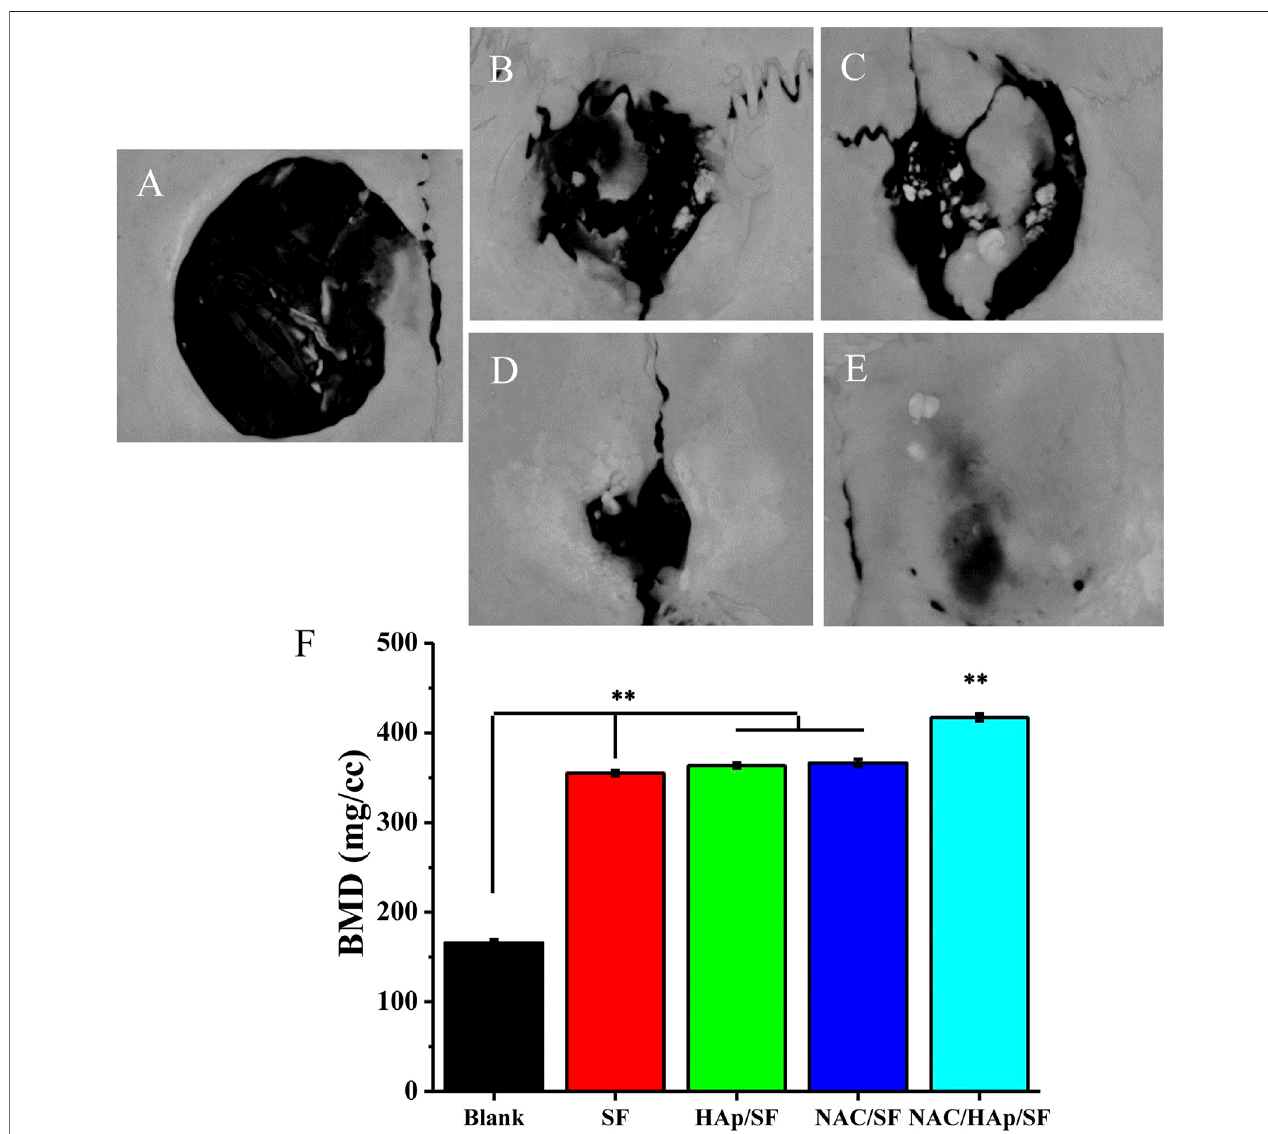
FIGURE10 | CTexaminationof thewhole calvarias (A – E) and bone mineral density ofthe defects (F) 8 weeksafter implantation in vivo (A) blank, (B) SF, (C) HAp/ SF, (D) NAC/SF, and (E) NAC/HAp/SF groups. * p < 0.05, ** p < 0.01, n (cid:1) 3.